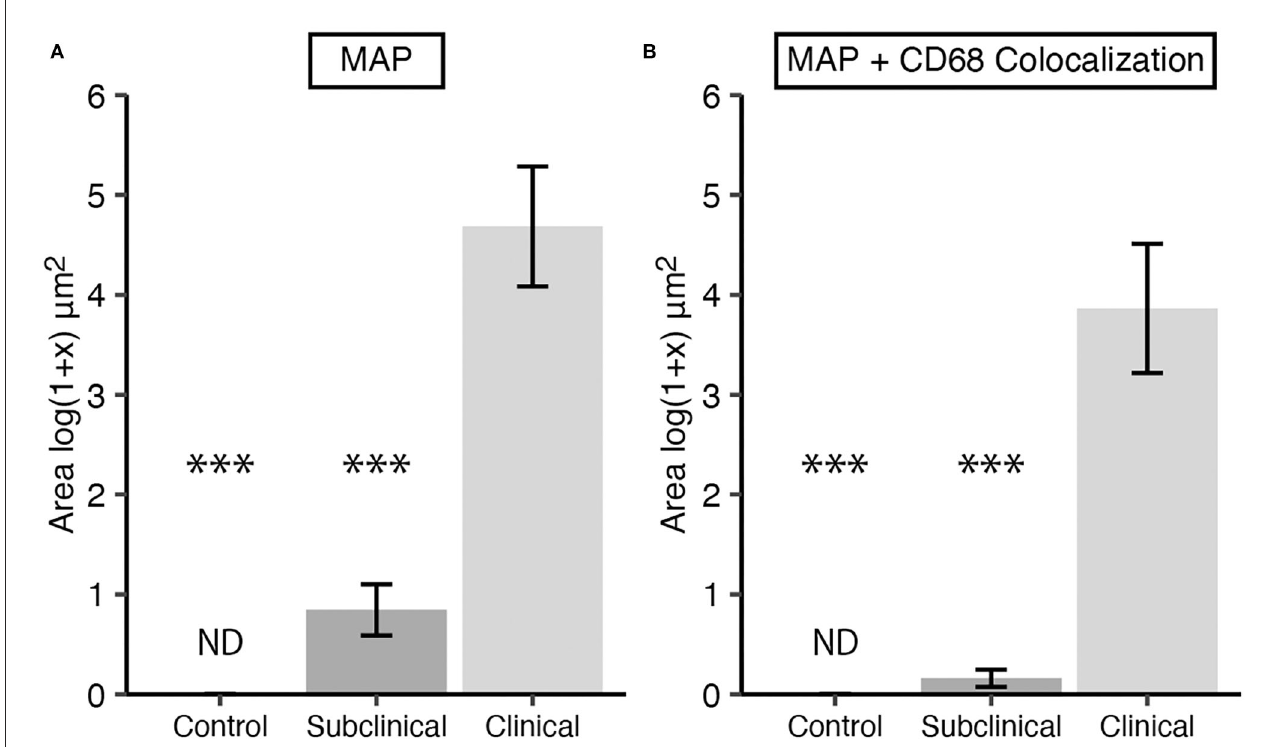
FIGURE2 Mycobacterium avium subsp. paratuberculosis (MAP) burden in frozen sections of mid-ileal tissue from dairy cows. Animals were stratified into groups by natural MAP infection (clinical n = 9, subclinical n = 9) or JD- controls ( n = 8). (A) Total MAP and (B) MAP within macrophages, defined as MAP colocalization with CD68, were measured. Data are presented as the mean fluorescence area [log(1 + x) µ m 2 ] ± SE and significance is indicated as *** < 0.001 as compared to the clinical group. Non-detected measurements are indicated by